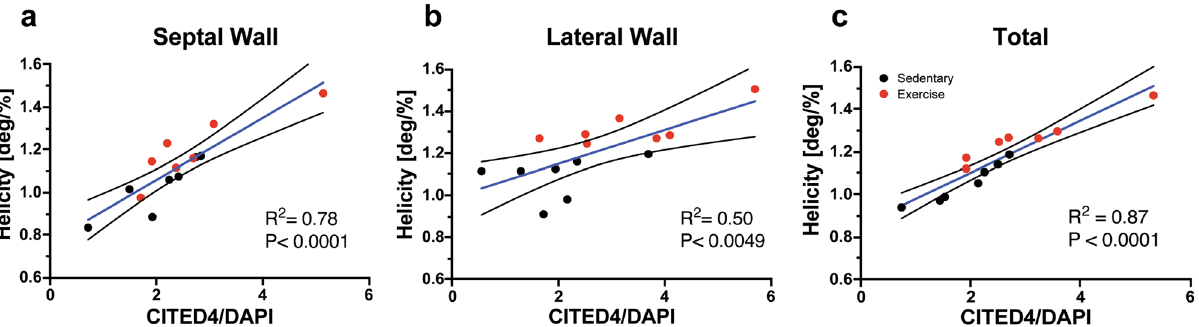
Fig. 5 Regional helicity changes are signi fi cantly correlated with CITED4/DAPI expression. a – c Simple linear regressions of CITED4/DAPI signal and helicity within the septum, lateral wall and averaged across all AHA sections. Black dots represent sedentary animals and red dots represent exercised animals. The blue line represents the total simple linear regression of both groups. * P < 0.05, ** P < 0.01, *** P < 0.001. Data presented with mean and 95% con fi dence interval.